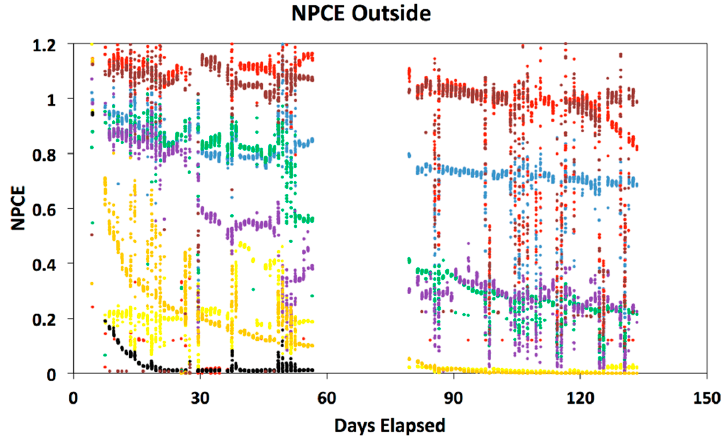
Figure 2. Graph displaying the outdoor normalized power conversion efficiency (NPCE) curves for each cell group. Colors correspond to labels in Table 1.